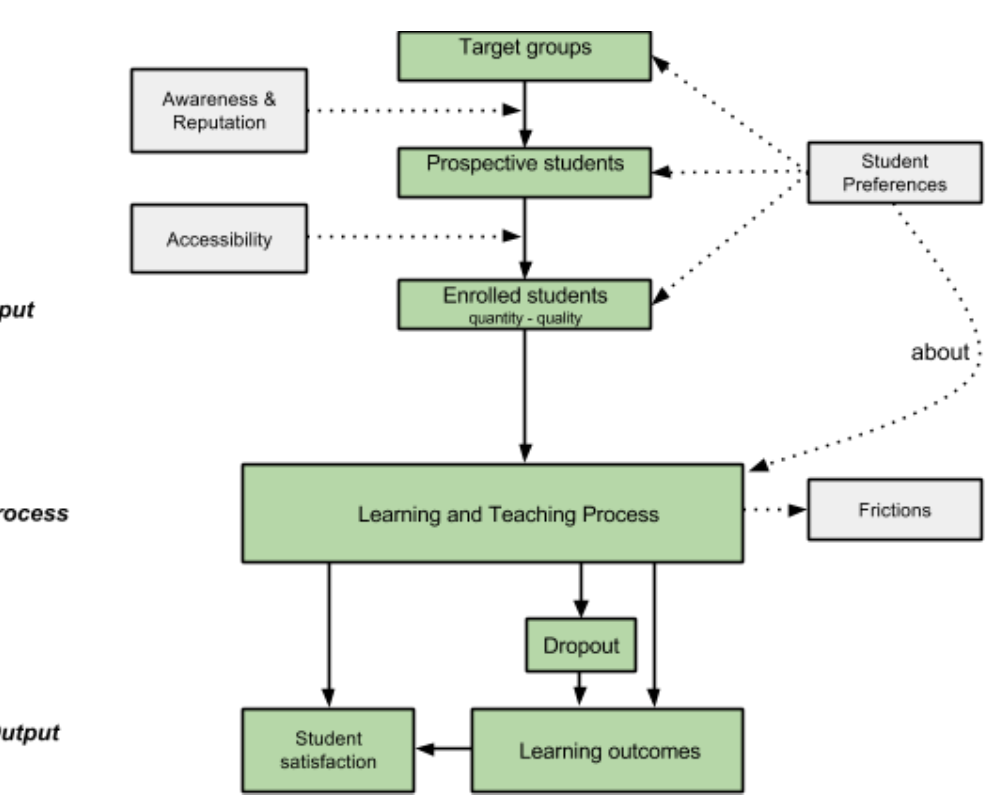
Figure 1. Student preferences positioned in a model of the educational